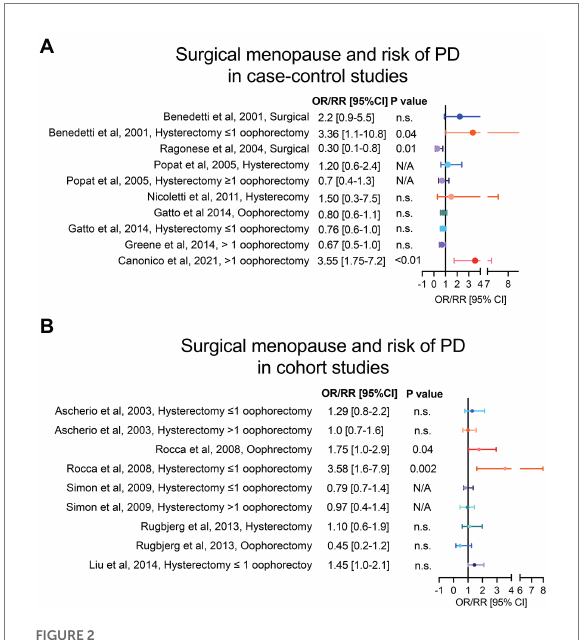
FIGURE 2 Type of menopause and risk of PD. Panel (A) shows case–control studies and panel (B) cohort studies that have analysed the risk of PD in women with surgical menopause compared to women with natural menopause. For each study, we reported the adjusted OR/RR and 95% CI with level of statistical significance (p value). OR = odds ratio, RR = relative risk, 95% CI = 95% confidence of